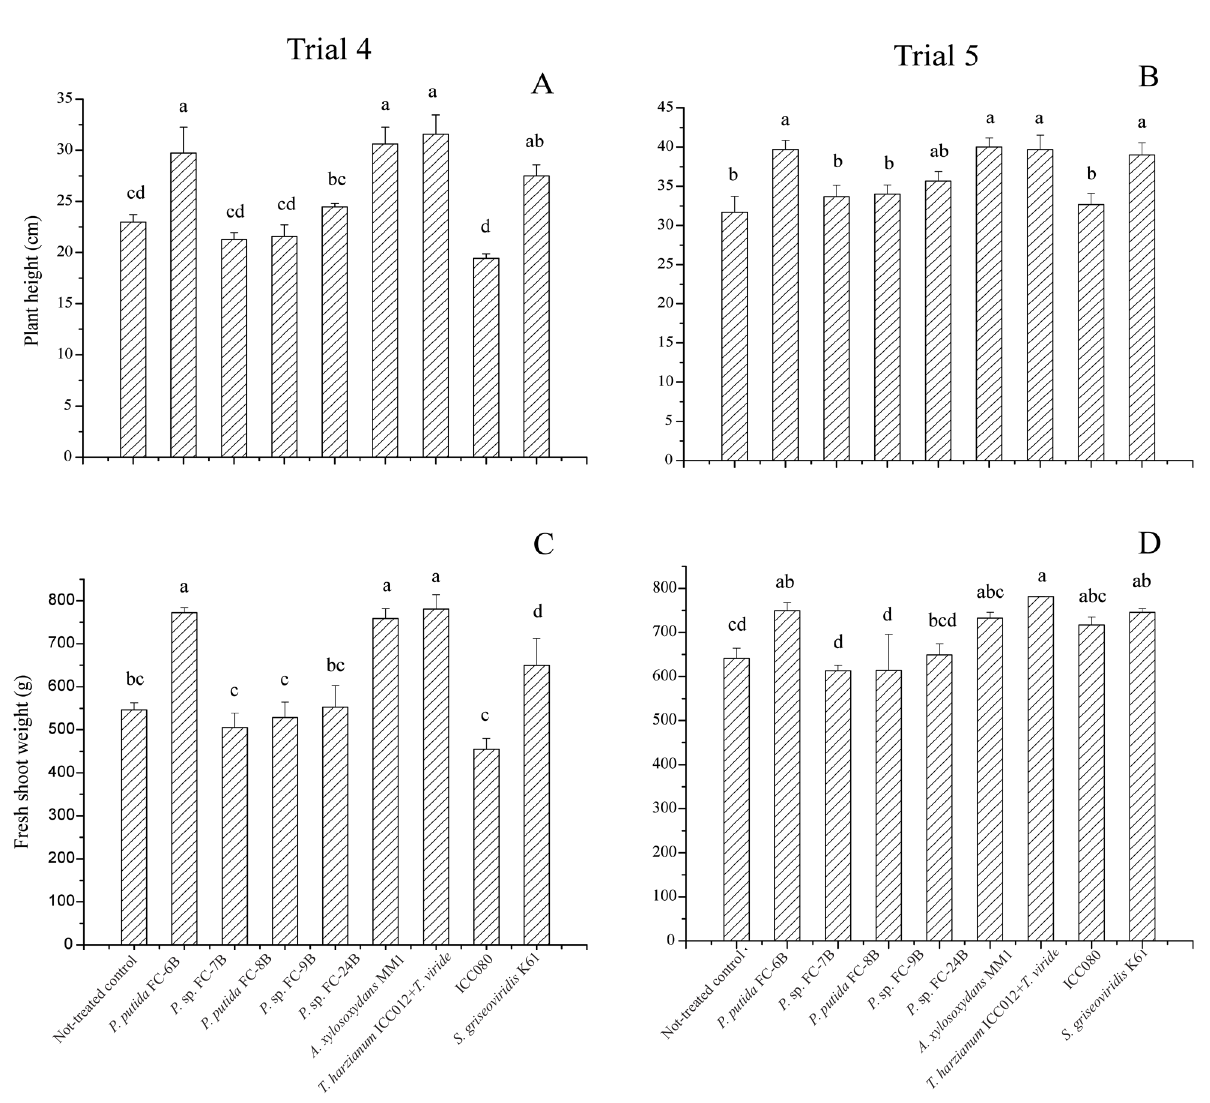
Figure 3. Plant growth promoting activity of biocontrol agents on tomato in the absence of the pathogen 52 days after transplanting, expressed as plant height (cm) and fresh shoot weight (g). Vertical bars represent the standard error of three replicates in A and C (trial 4), and B and D (trial 5). Means designated by the same letter are not significantly different ( P <0.05) according to Duncan’s